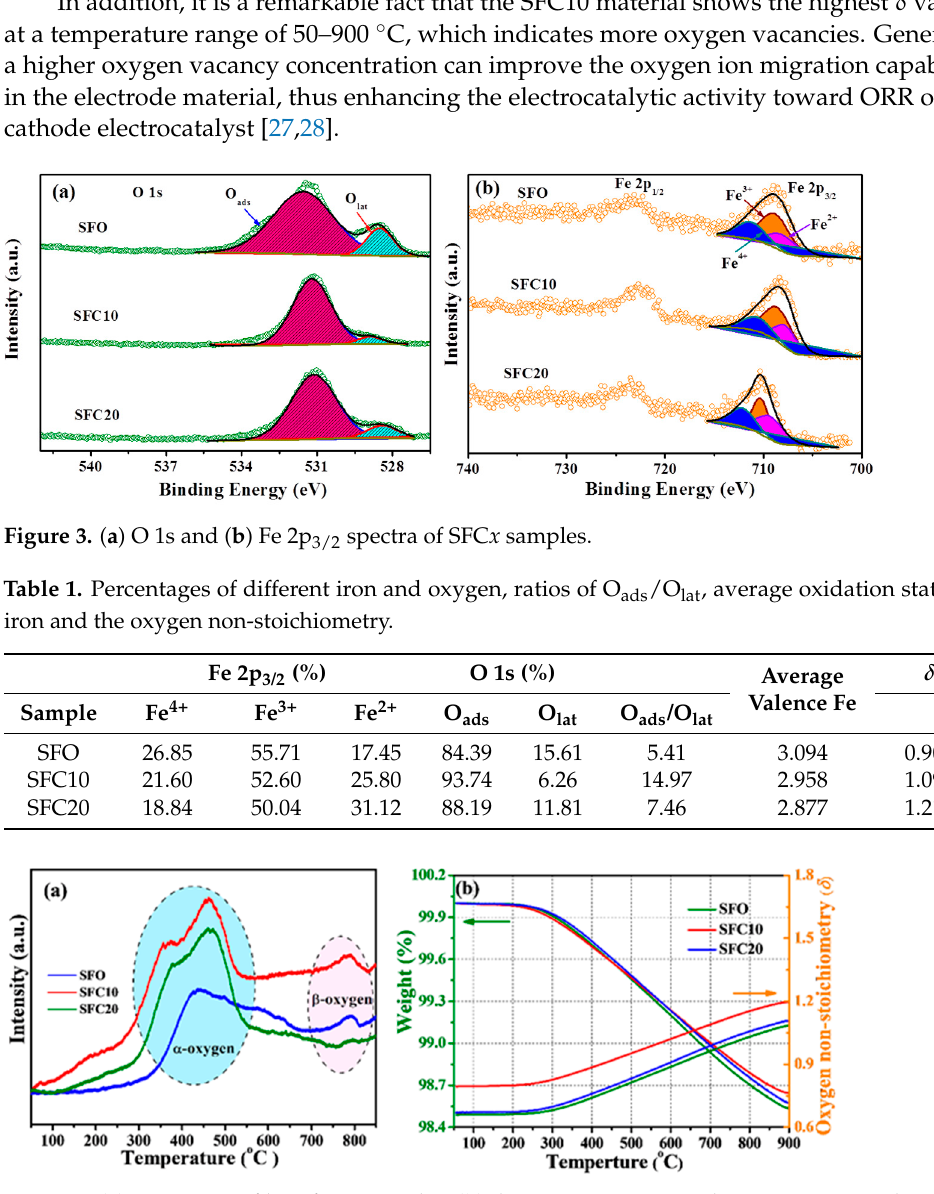
Figure 4. ( a ) O 2 -TPD profiles of SFC x oxides; ( b ) thermogravimetry and oxygen non-stoichiometry of the SFC x samples.